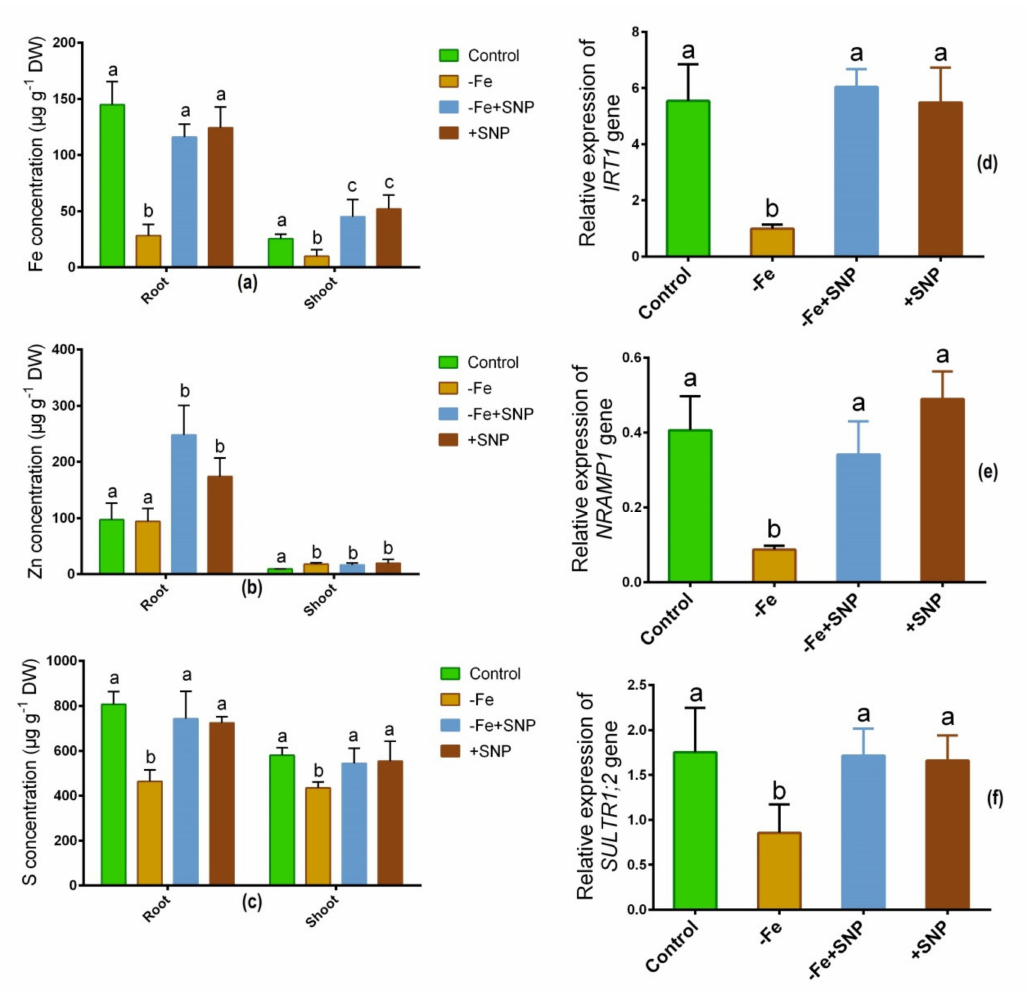
Figure 6. Fe ( a ), Zn ( b ) and S ( c ) concentration, along with IRT1 ( d ), NRAMP1 ( e ), and SULT1;2 ( f ) candidate gene expression in alfalfa cultivated with different growth conditions: control (25 µ M FeNaEDTA); − Fe (0.1 µ M FeNaEDTA); − Fe (0.1 µ M FeNaEDTA) and sodium nitroprusside (SNP, 100 µ M) as nitric oxide (NO) donor; and SNP (100 µ M). Different letters above the error bar indicate significant differences ( p < 0.05) among means ± SD of treatments ( n =